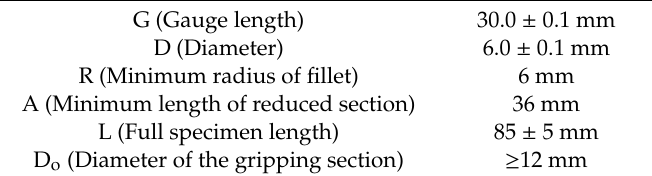
Figure 2. Tensile sample dimensions. Table 2. Tensile sample dimension.